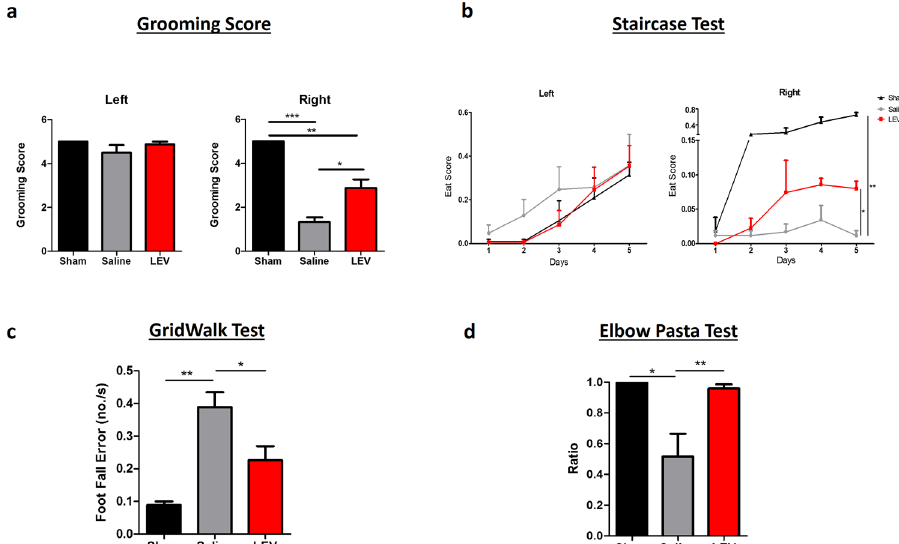
Fig. 2 LEV treatment promotes functional recovery after cervical SCI. a Grooming score test demonstrated that LEV promotes a signi fi cant functional recovery of the right forelimb. LEV-treated animals were capable of reaching the eye level with the lesioned paw, while saline- treated animals were only capable of reaching underneath the snout. b The behavioral analysis of the staircase test revealed that LEV-treated animals were able to eat more sugar pellets with the right forepaw when compared to saline-treated rats. c The gridwalk test was also performed to complement fi ne locomotor recovery assessment. LEV treatment was able to signi fi cantly reduce the rate error of the animals while exploring the grid. d Finally, the elbow pasta test was also performed to assess bimanual dexterity of the rats. On this behavioral analysis, LEV-treated animals demonstrated higher motor abilities being able to eat the pasta with both forepaws for longer time periods than the saline treatment rats. Sham n = 3; Saline n = 6; LEV n = 8. Values shown as mean ± SEM. * p < 0.05; ** p < 0.01; *** p <